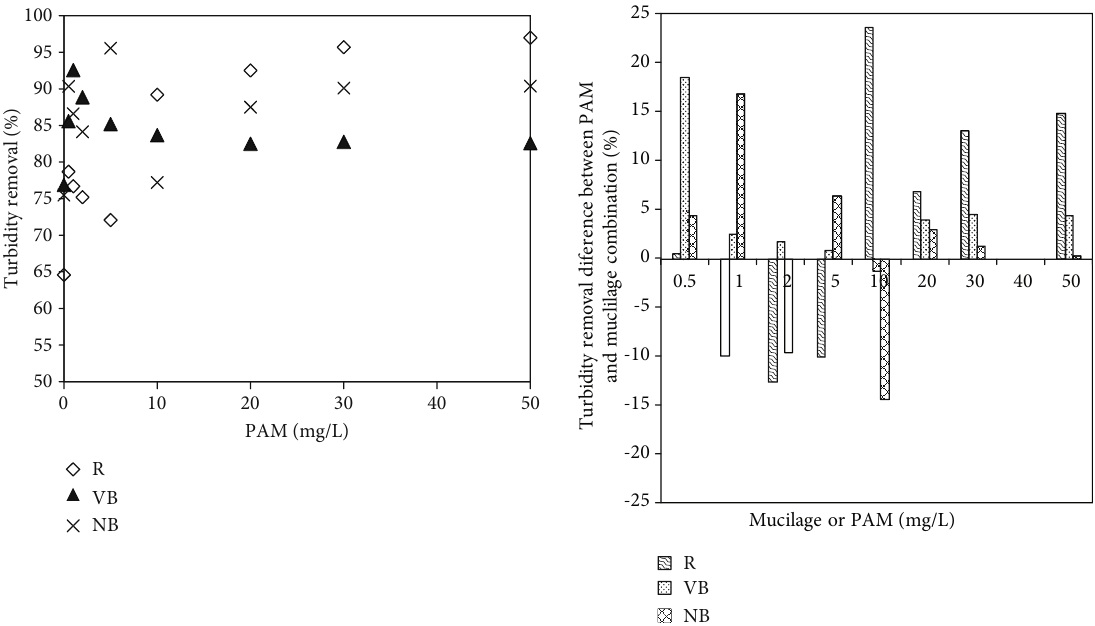
Figure 5: Turbidity removal of PAM in combination with PACl and its comparison with those of